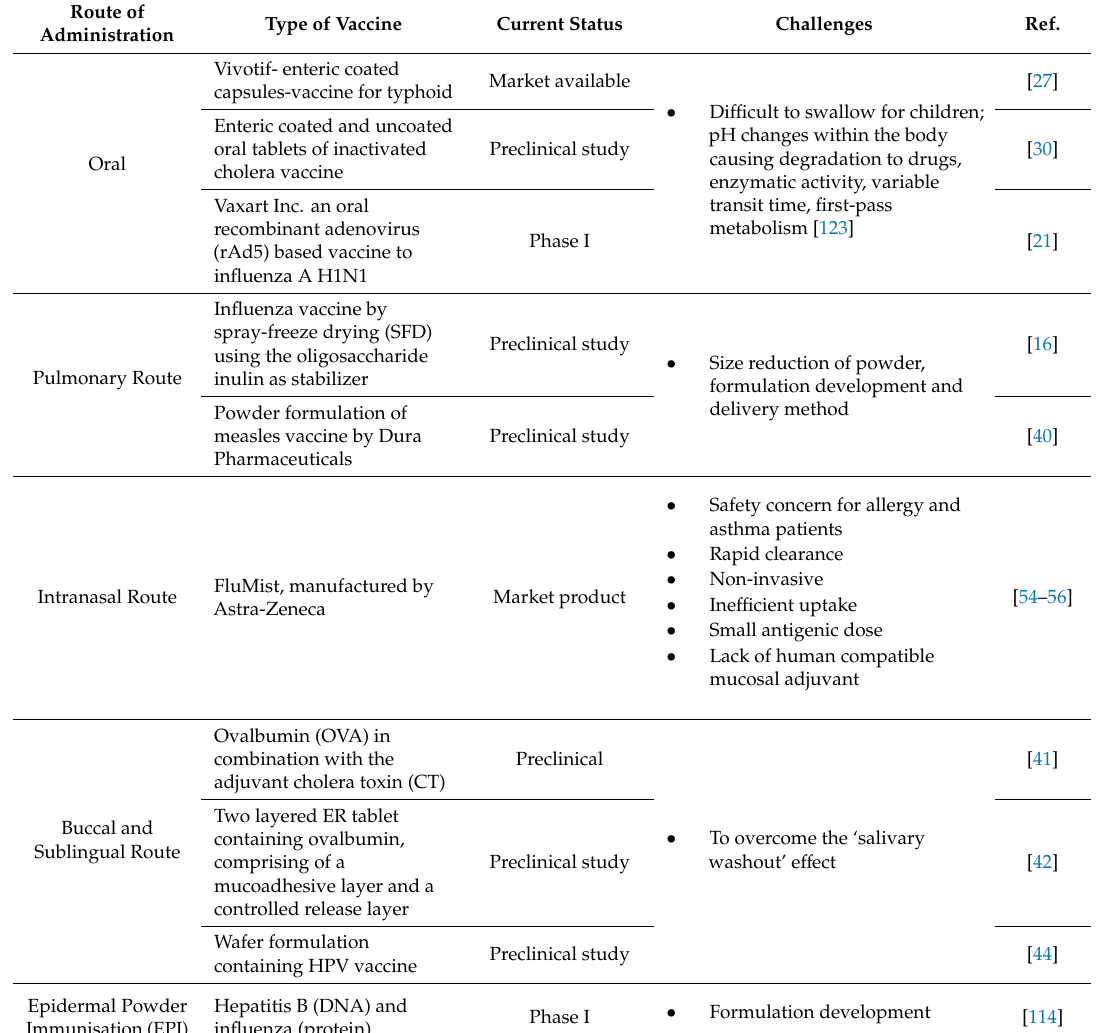
Table 4. Summary of the di ff erent routes of administration for solid dose vaccine delivery and the associated